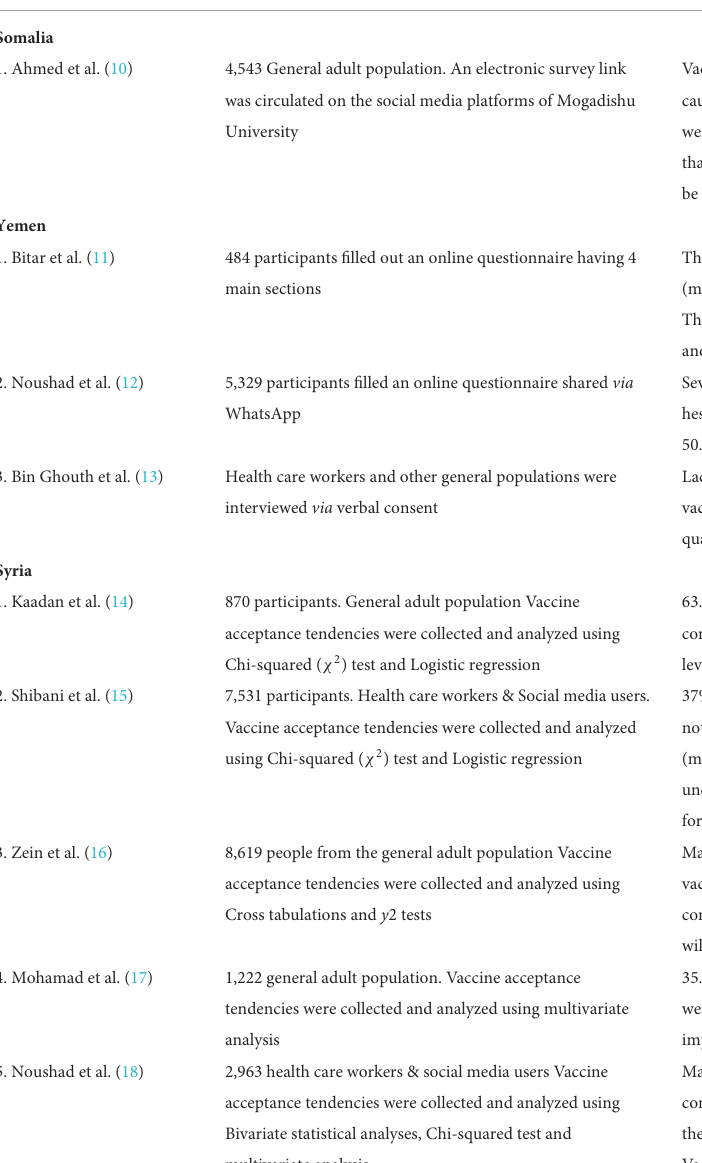
TABLE 1 Summary of studies on vaccine hesitancy in cohorts in conflict settings (i.e., Somalia, Yemen, Syria, Afghanistan, and